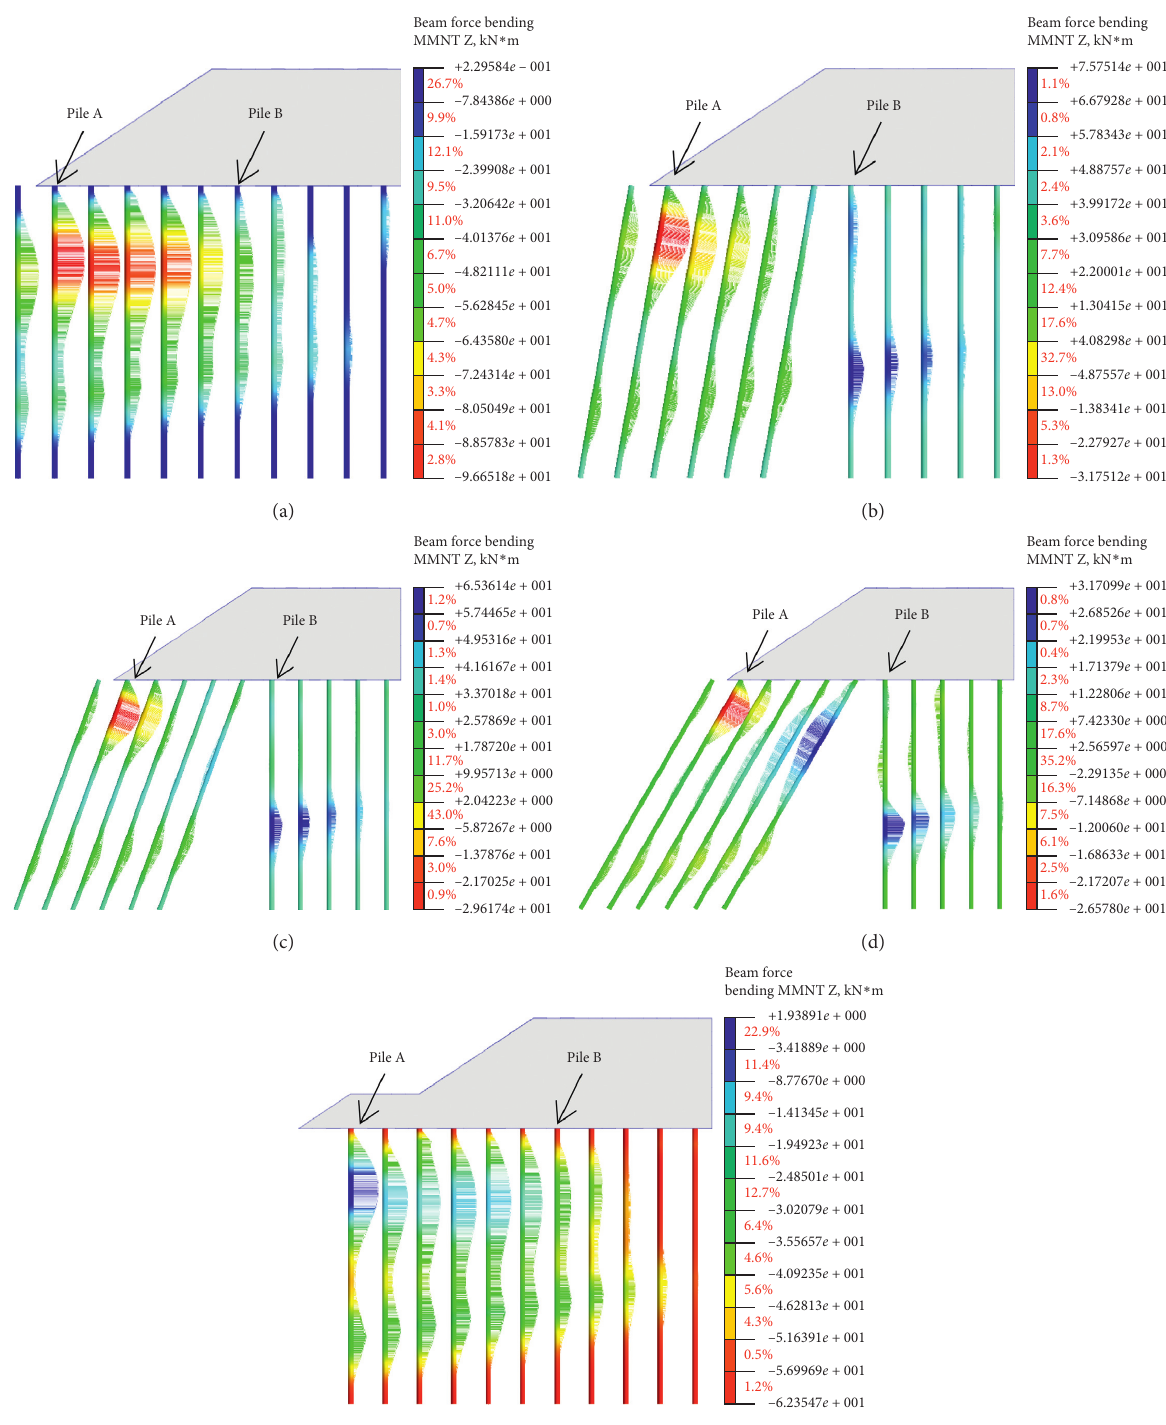
Figure 12: Bending moment distribution of PCP piles. (a) Program A, (b) Program B, (c) Program C, (d) Program D, and (e) Program